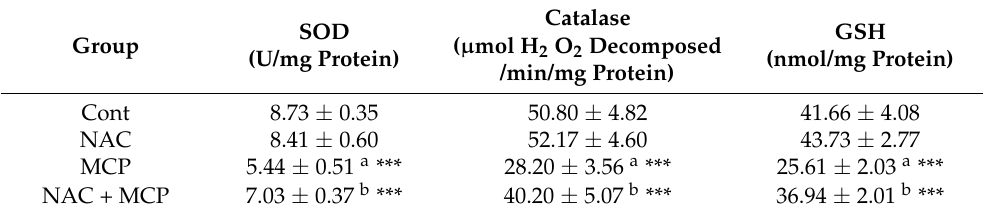
Table 2. Effects of NAC pretreatment on MCP exposure induced alterations in hepatic antioxidant status of